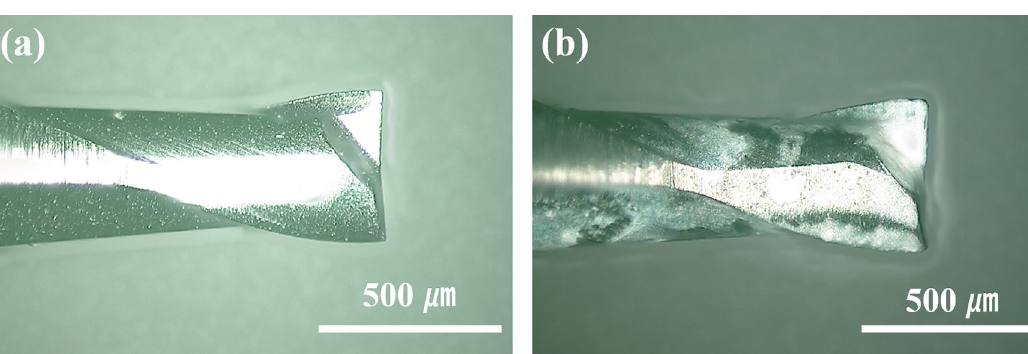
Figure 7. Microscope images of the machined inner pattern: ( a ) the first inner pattern, ( b ) the 72nd inner pattern, and ( c ) the 144th inner pattern.